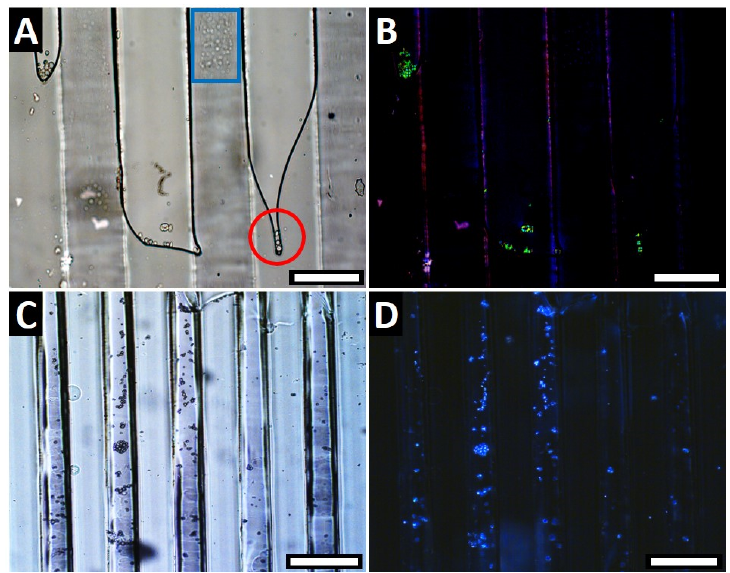
Figure 2. ( A ) In situ LM image during the infiltration of the CaCO 3 crystallization solution in a MUO-modified MCTS shows small CaCO 3 particles at the liquid-air boundary. The red circle highlights the resulting CaCO 3 islands and the blue square indicates non-crystalline aggregates on the channel walls (scale 50 µm); ( B ) PLM image of the area of ( A ) shows the crystallinity of the CaCO 3 particles in green (scale 50 µm); ( C ) LM image after drying in air shows the CaCO 3 particles inside the channels (scale 100 µm); and ( D ) PLM image of the area of ( C ) indicates the crystallinity of the particles in the channel system by their birefringence (scale 100 µm).